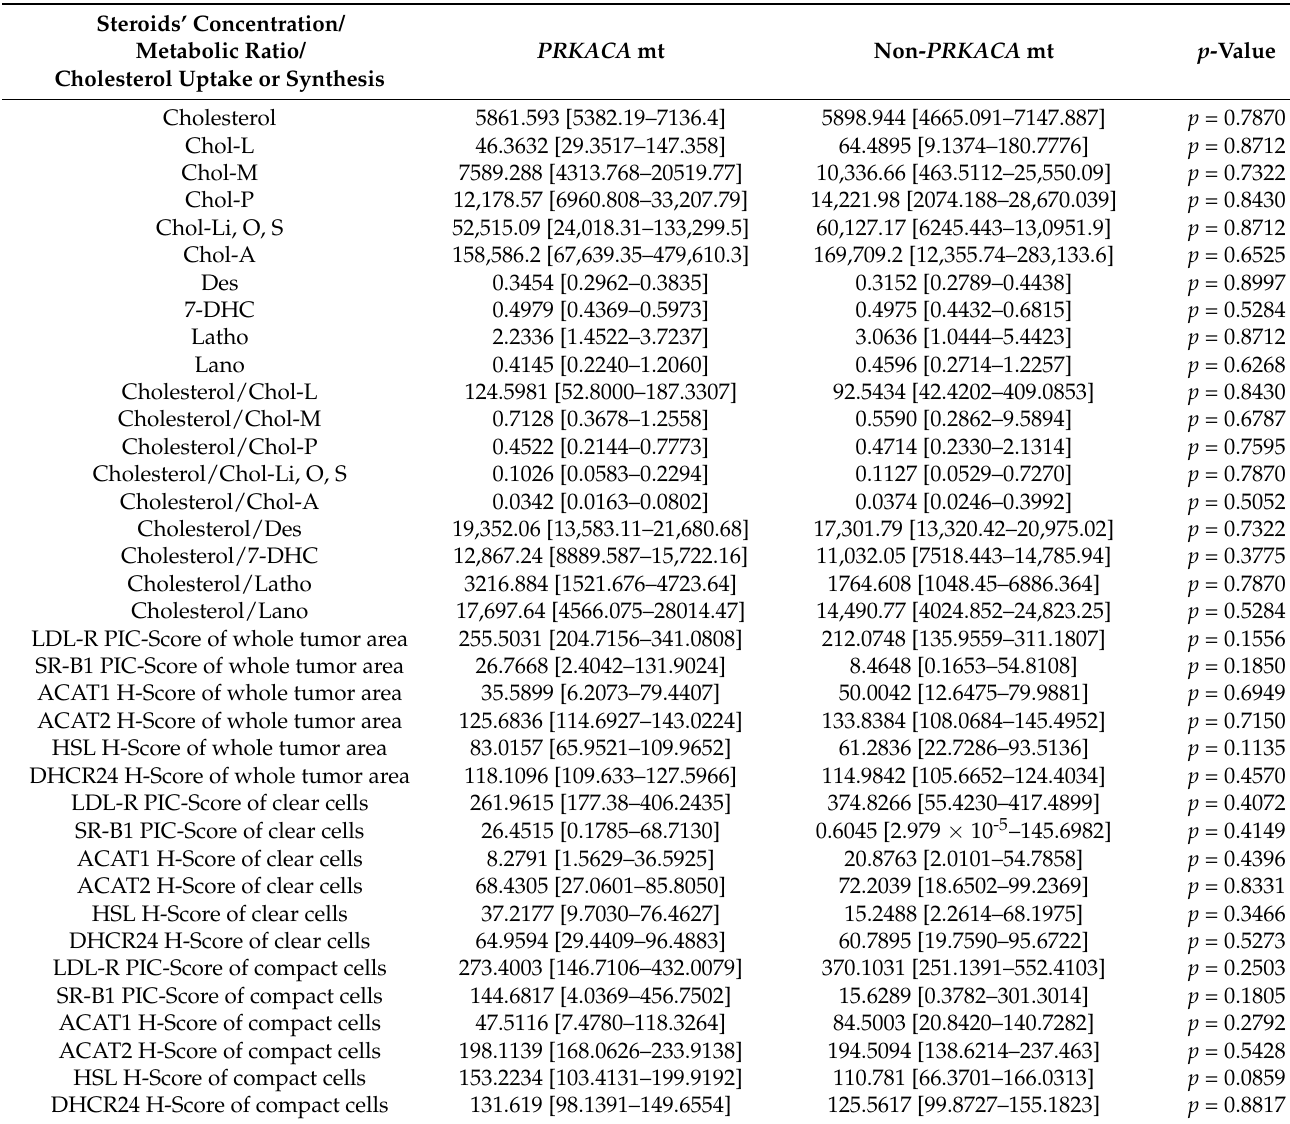
Table 3. Differences in cholesterol uptake/synthesis between PRKACA mt and non- PRKACA mt. HSL in compact cells tended to be higher in PRKACA mt cases but the difference did not reach statistical significance. The values of each factor were represented by the median [Range: 1st quartile, 3rd